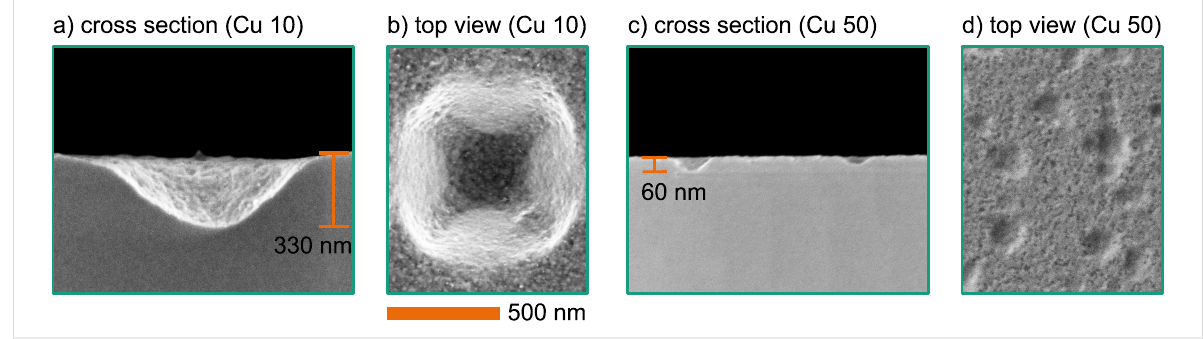
Figure 8: SEM images of etched structures using Cu particles, etched for 10 min with 1.73 mol/L HF and 10 mmol/L H 2 O 2 ((a): cross section; (b): top view), and with 50 mmol/L H 2 O 2 ((c): cross section; (d): top view).